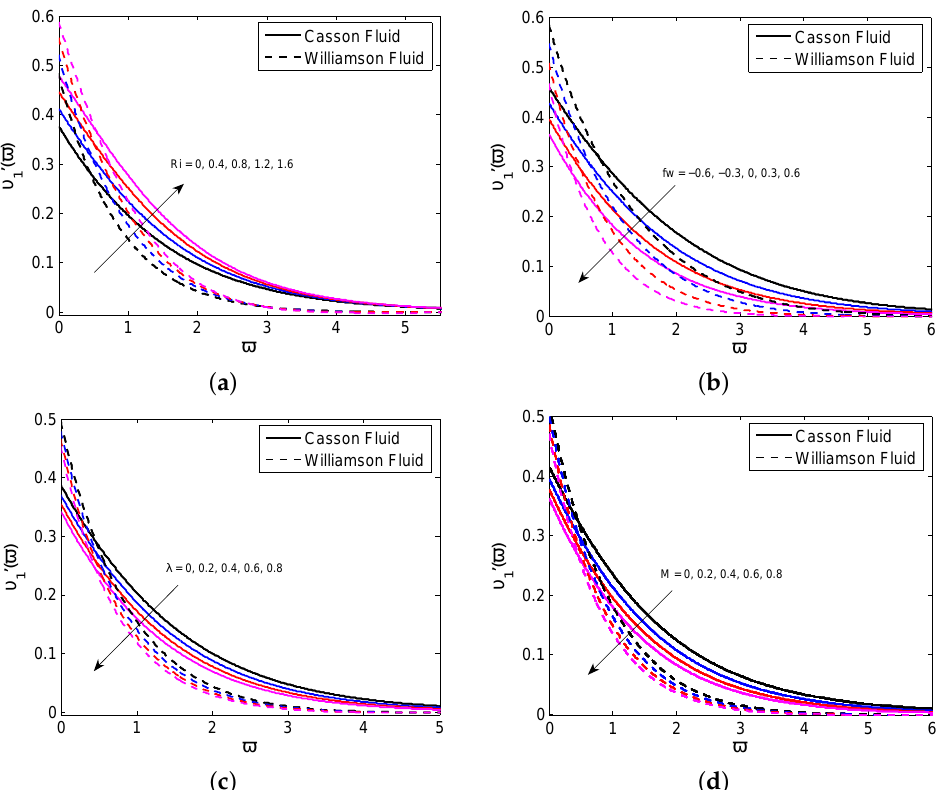
Figure 2. The nanofluid velocity for various values Ri ( a ), fw ( b ), λ ( c ) and M ( d ).